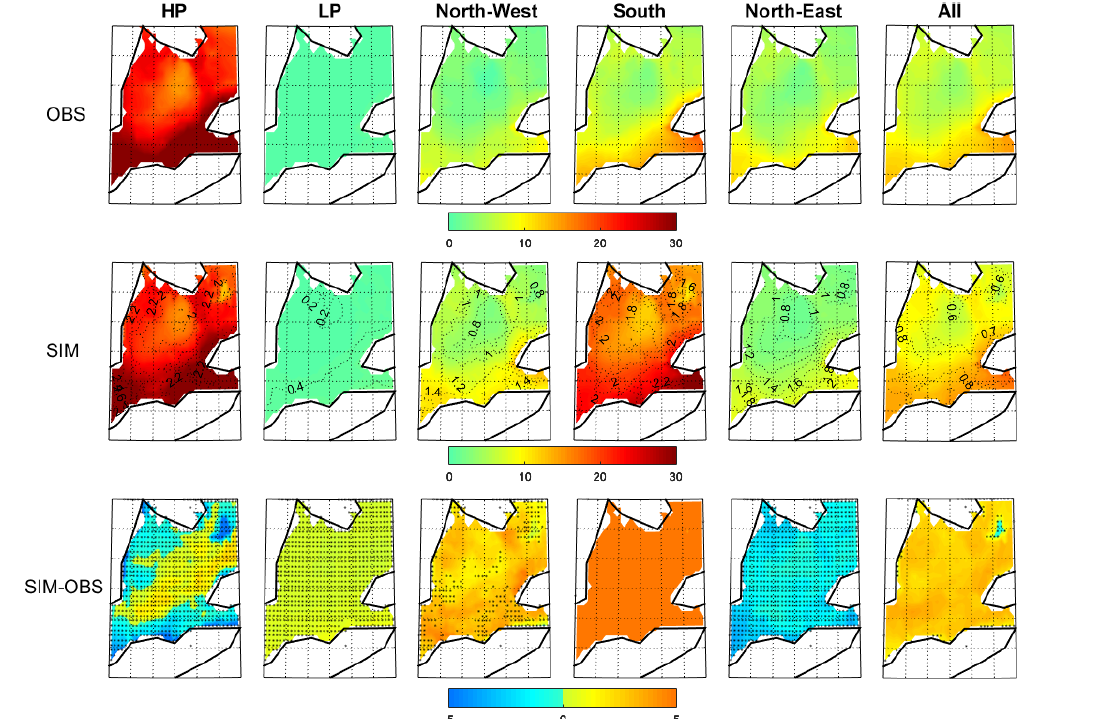
Figure 5. Percentage of DJF number of warm events ( T > 5 ◦ C) relative to DJF occurrence of weather regime in the historical period (1961– 1990) for the observations (upper panels), simulations from CRCM5-LE 50-member average (middle panels) and simulations minus obser- vations (lower panels). The dotted lines in the middle panels represent the standard deviation of the 50-member CRCM5-LE simulated percentage. Stippled regions in the lower panels indicate where the observations lie within the CRCM5-LE ensemble